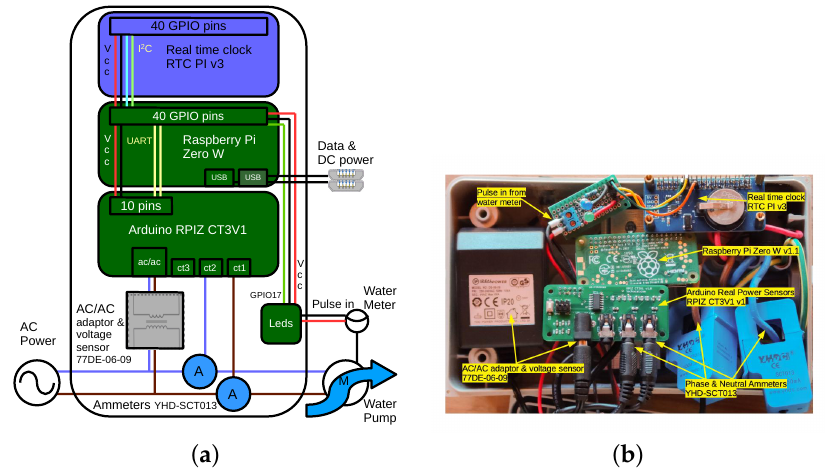
Figure 2. Board and sensor assembly. ( a ) Hardware block diagram. ( b ) Sensors and